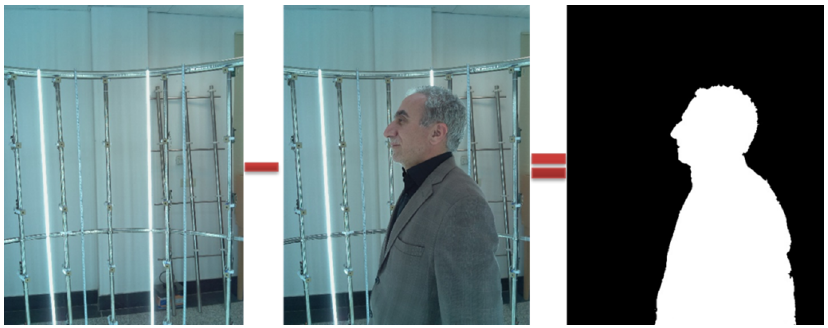
Figure 9. Removing the background by capturing two images from a single viewpoint (with and without the